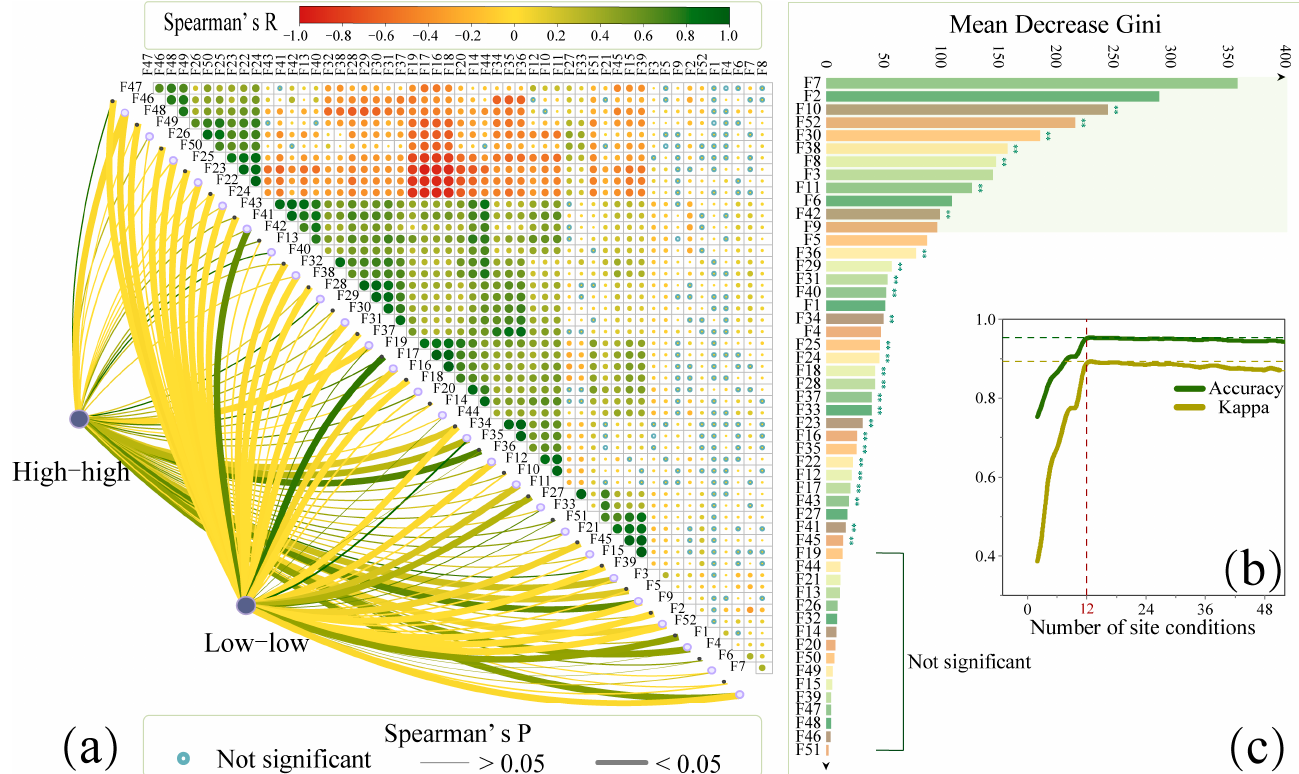
Figure 4. Spearman correlation between locations of the carbon density clustering and each site condition ( a ); strengths of site conditions of model variables based on Gini values ( b , c ). ** indicates significant differences at p < 0.01 (Significant test).